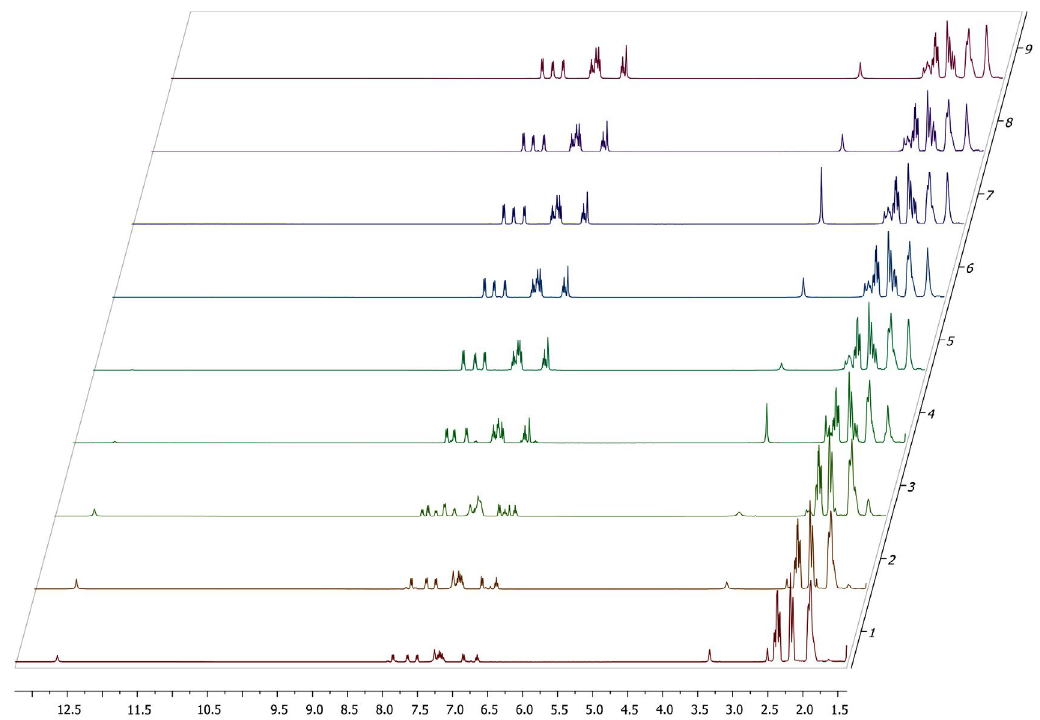
Figure 1. 1 H NMR monitoring of the reaction progress of 4-methylcyclohexanone and 2-(2’-aminophenyl)-1 H -benzimidazole at 20 minute inter-